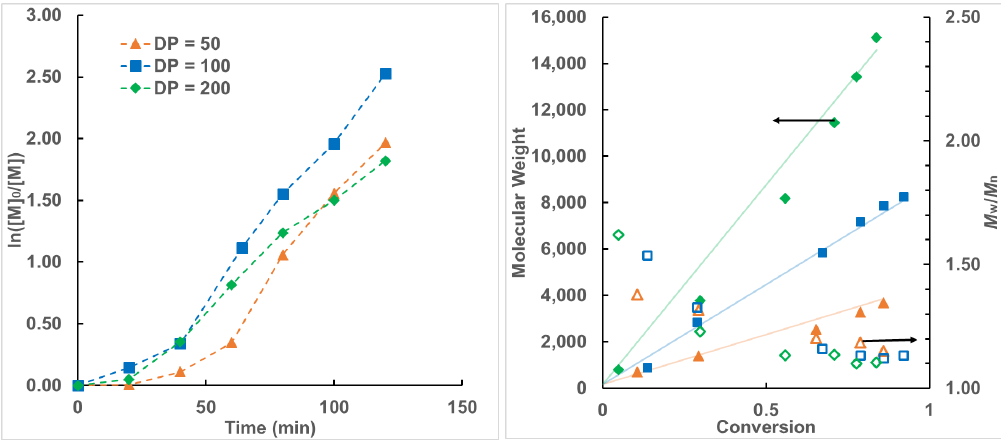
Figure 1. (Left) Kinetic plots of ln ([ M ] 0 / [ M ]) vs. time and (right) plot of number-average molecular weights M n and M w / M n values vs. conversion for ATRP of MA by continuous feeding of Cu(I) activators. [ MA ] 0 : [ CuBr 2 ] 0 : [ Me 6 TREN ] 0 = 100 : 0.005 : 0.01 at 60 ◦ C with 100mmol MA and 2, 1, and 0.5 mmol MBrP, in 5mL of DMF; 0.04mmol CuBr/Me 6 TREN in 2mL of MeCN was added in